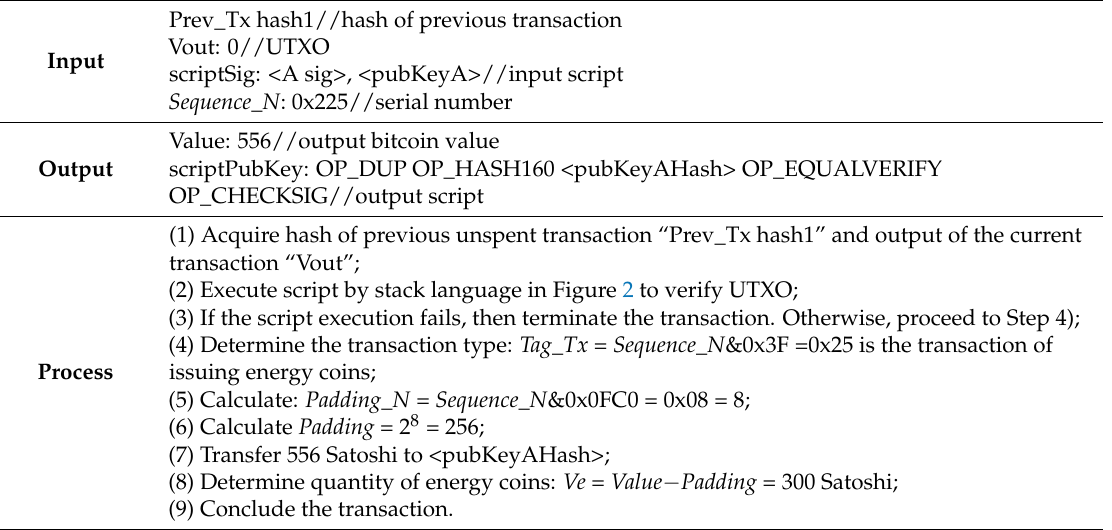
Table 3. Transaction of issuing energy